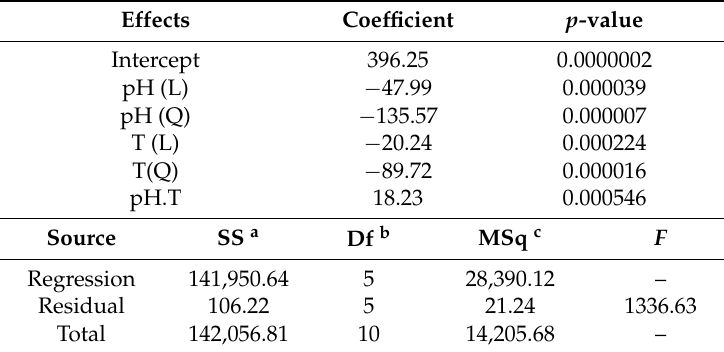
Table 6. Coefficients values and ANOVA for laccase